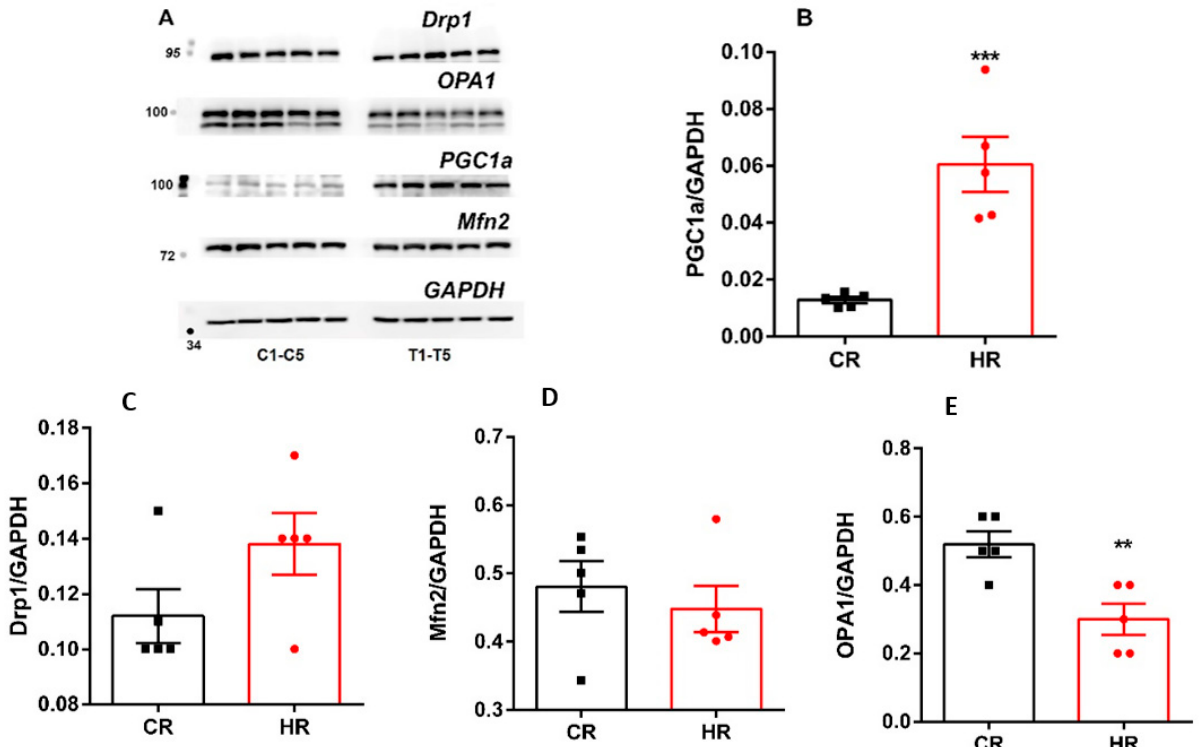
Figure 5. Immunoblotting analysis of mitochondrial dynamics and biogenesis proteins in liver tissue of control and hyperthyroid rats. ( A ) Representative Western blot of Drp1, OPA1, Mfn2, PGC1 α , C 1 -C 5 -CR, T 1 -T 5 -HR. ( B – E ) Relative levels of appropriate proteins with respect to the loading control (GAPDH). CR, control; HR, hyperthyroidism. **— p < 0.02, ***— p < 0.001 as compared with the control data ( n = 5).